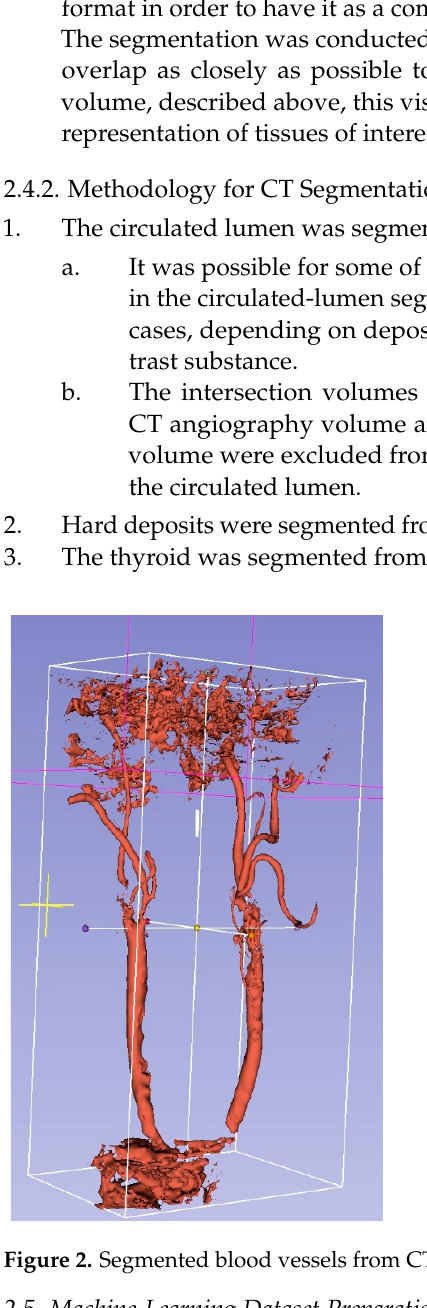
Table 1. Dataset total frames per class.